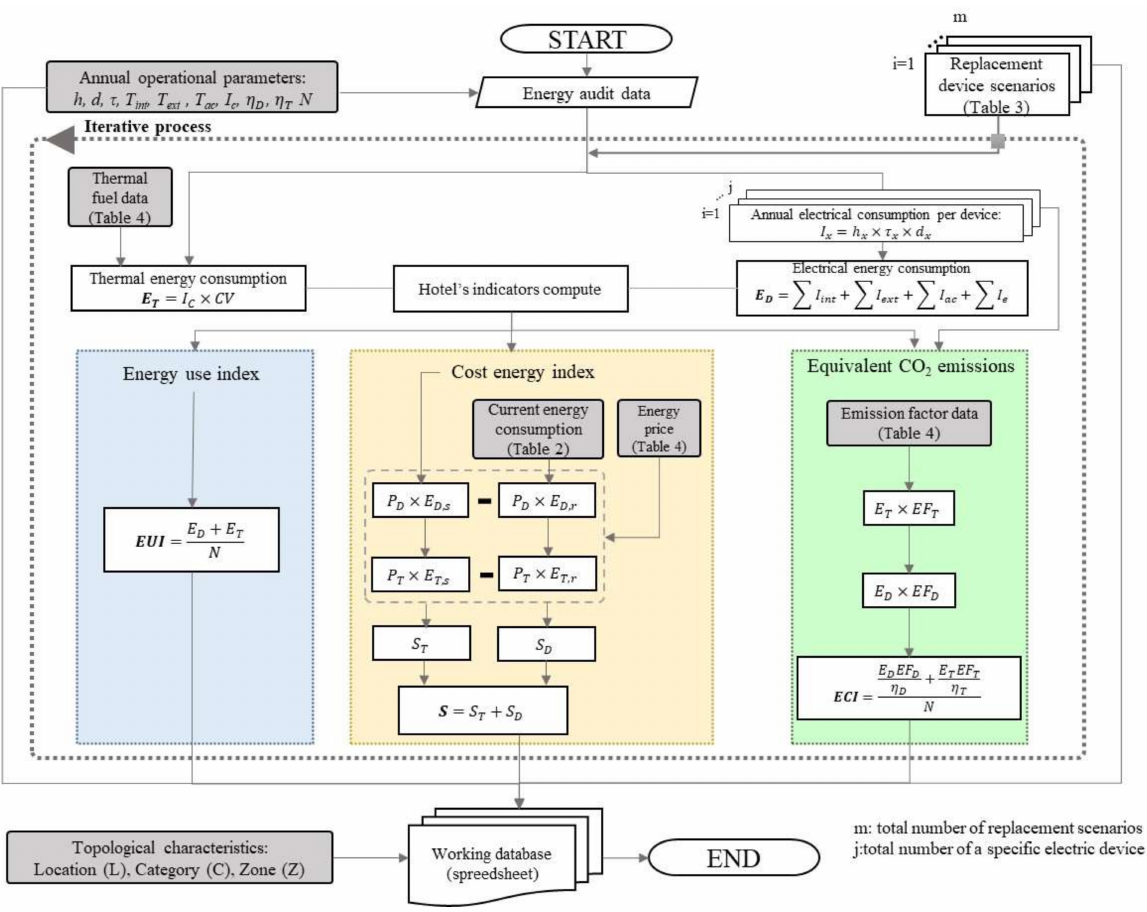
Figure 3. Flow chart of the process for assessing the hotels’ economic, energy, and environmental- performance indicators based on the device-replacement